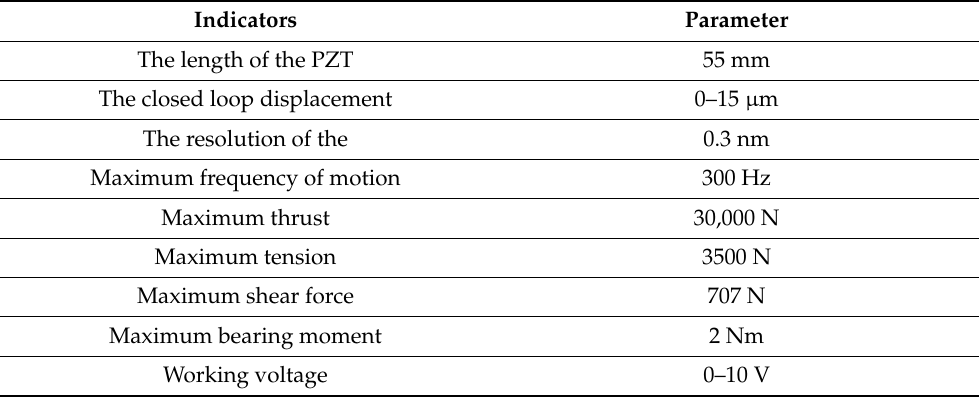
Table 1. Main technical parameters of the P-235.1s PZT